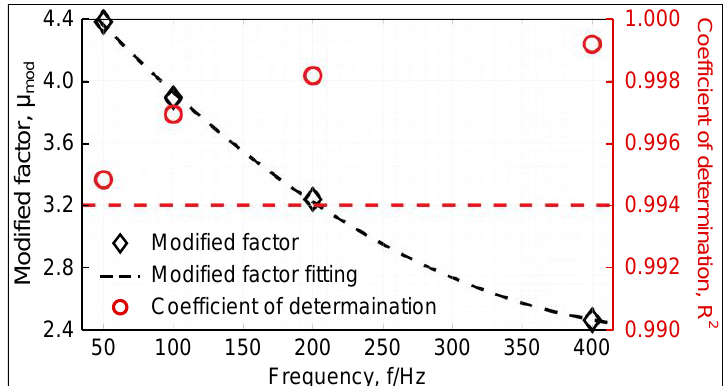
Figure 17. Loss correction factor µ and R 2 at different frequencies.